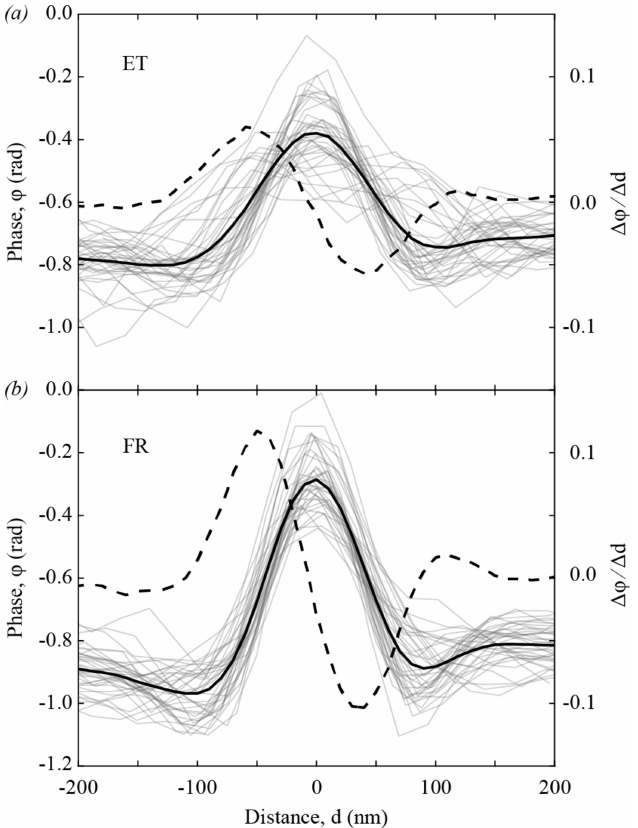
Figure 4 Line profiles (light-grey lines) across all 37 spokes of the test pattern from the central ring to the next. The average line profiles (black lines) and their first derivatives (dashed lines) are shown for ( a ) externally triggered (ET) and ( b ) free-run (FR) data collection with interpolated